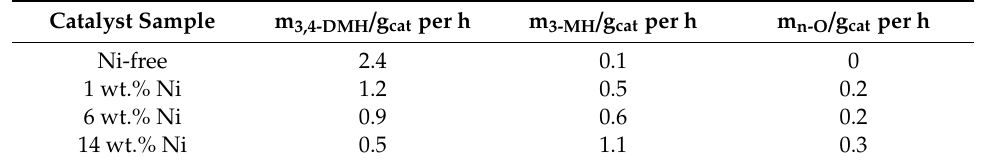
Figure 5. Part of octene isomers in product stream after oligomerization of n-butenes on amorphous aluminosilicates with varying nickel content between 0 and 14 wt.% in continuous operation (100 °C, liquid phase, average over 180 h on stream); ( A ) part of main products and ( B ) part of side products. Table 1. Mass of octene isomers formed over catalyst samples with different nickel content per gram